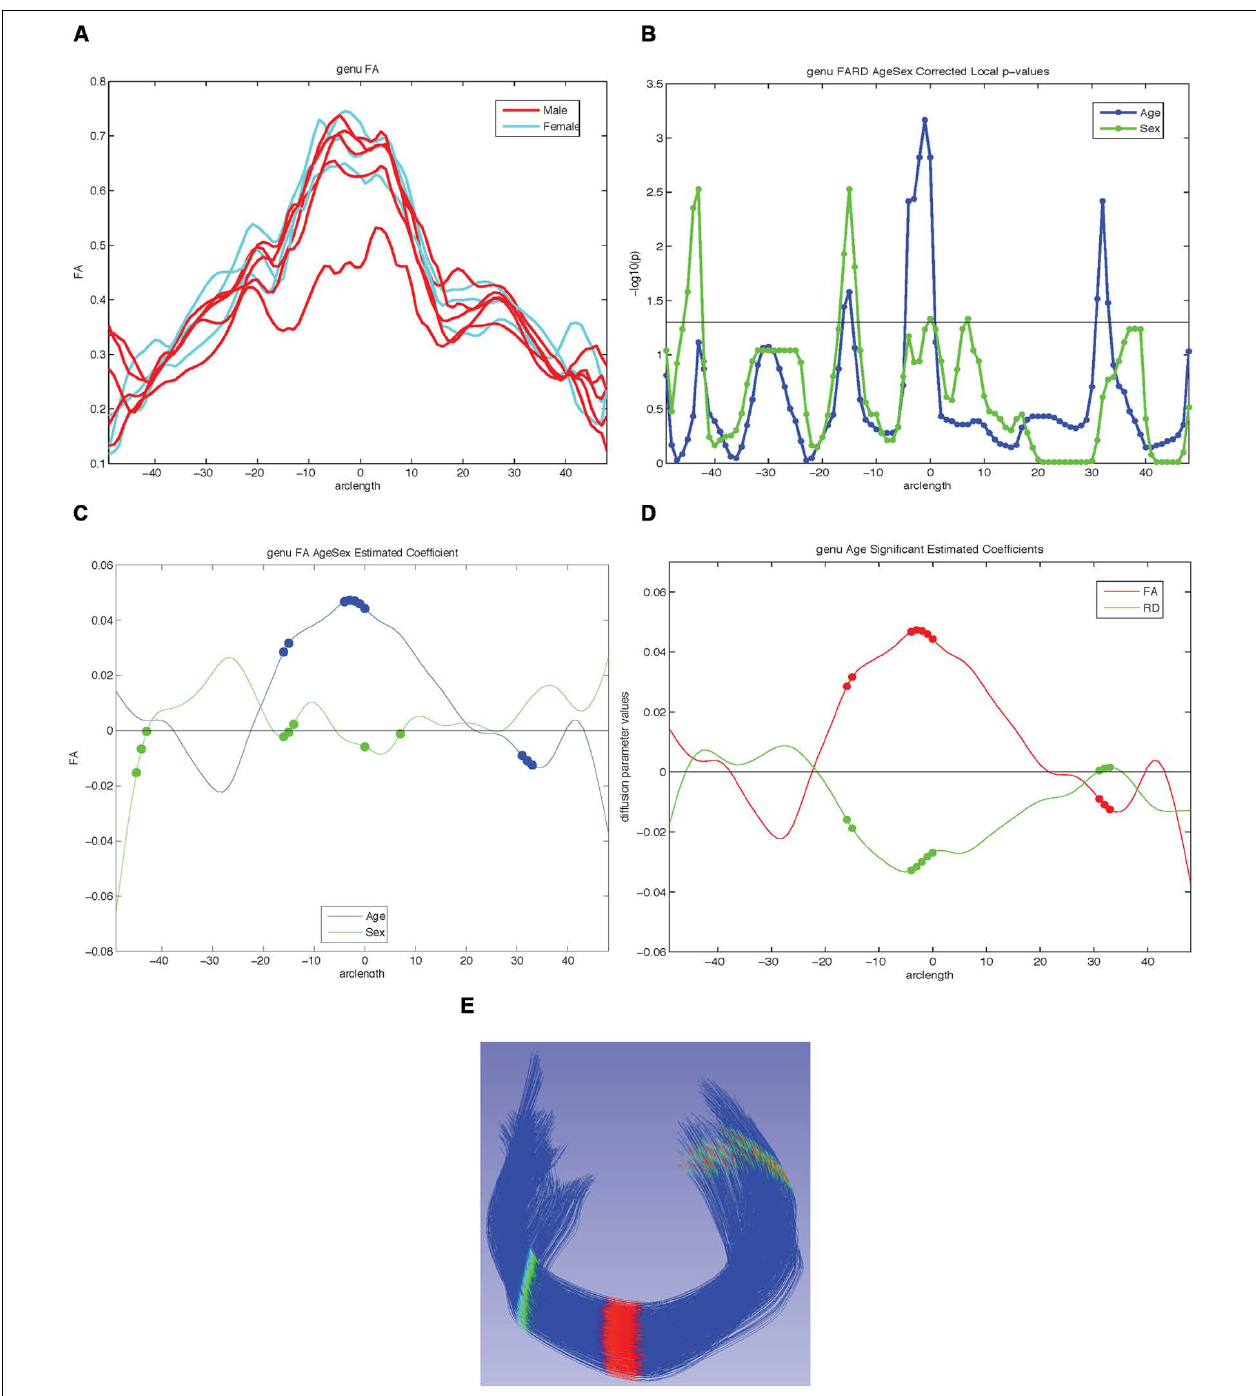
(E) Visualization of local statistics along the tract with 3D Slicer. Specifically this image reflects the corrected local p -values for the interaction between Age and FA for the genu [ (C) blue line, (D) red line]. All non-significant points are assigned a single value and color (dark blue here). Points that are significant then proceed from the next value on the color bar until the furthest end of the color bar. In the color bar shown, areas of significance are colored from cyan to red, with red areas indicating most significance. Any color bar available can be